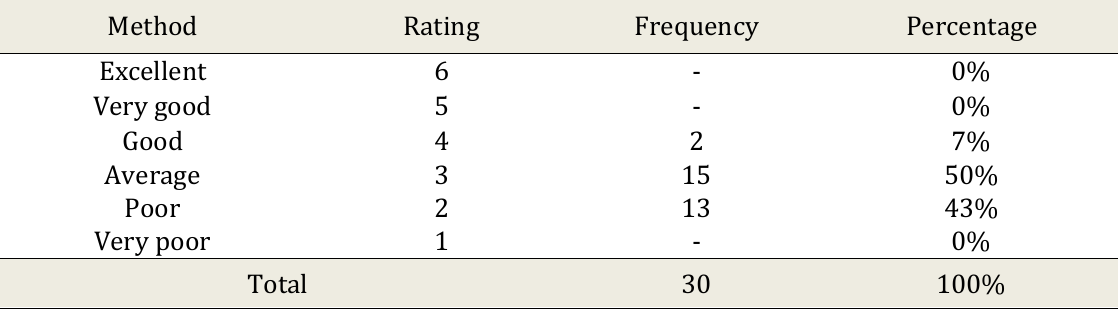
Table 4.5 The Rate Percentage of Students' Score of Fluency in Pretest Result in